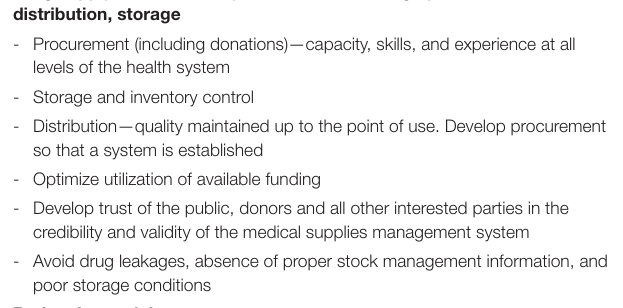
Drug supply and availability of medicines through procurement, distribution,